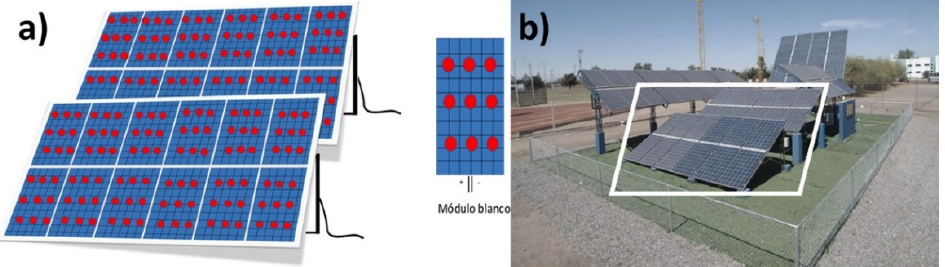
Figure 3. ( a ) Schematic representation of temperature measurements points of 24 PV spray-cooling modules and control PV module, and ( b ) photograph of PV